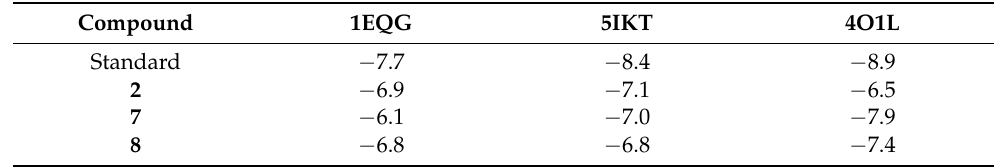
Table 3. Binding affinities (kcal/mol) of standard ligands and synthesized compounds that demon- strated analgesic activity against target proteins. Compound 1EQG 5IKT 4O1L Standard − 7.7 − 8.4